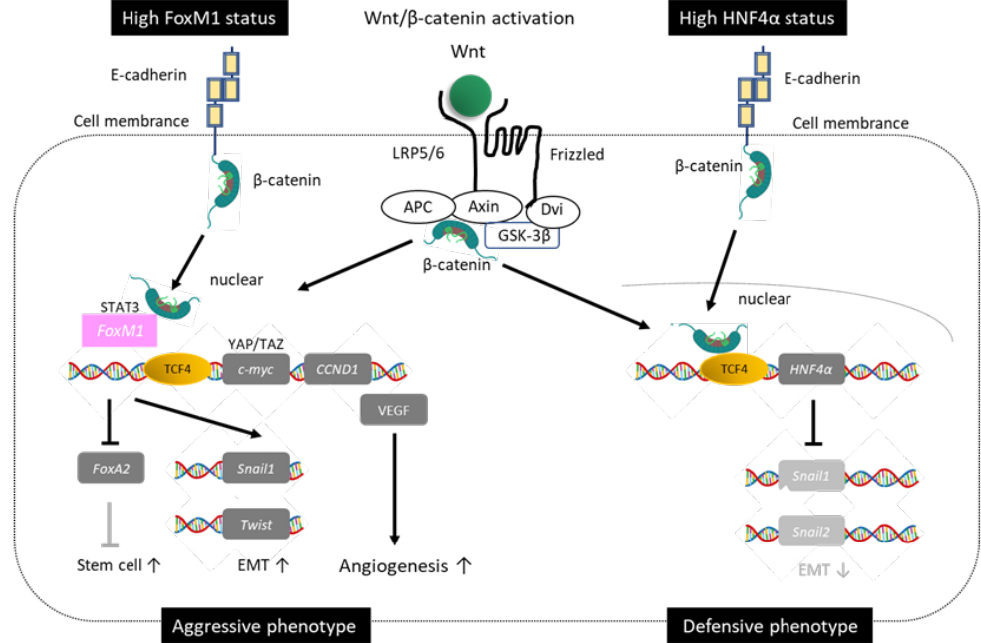
Figure 2. Duality of Wnt/β-catenin mutation (modified from [18]). Wnt/β-catenin mutations in HCC are divided into favorable and unfavorable phenotypes. HCC-specifically expressed tumor suppressor gene HNF4α is a target gene of Wnt/β-catenin signaling.